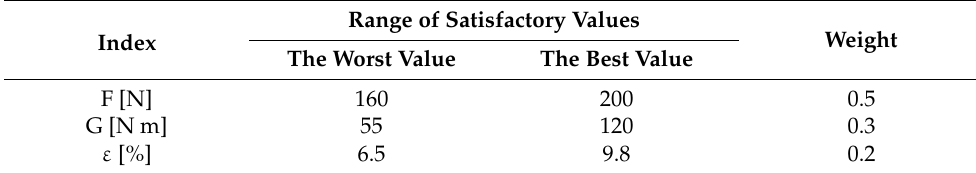
Table 1. Ranges of satisfactory values and weights attributed to the particular criteria for tapes A and B.